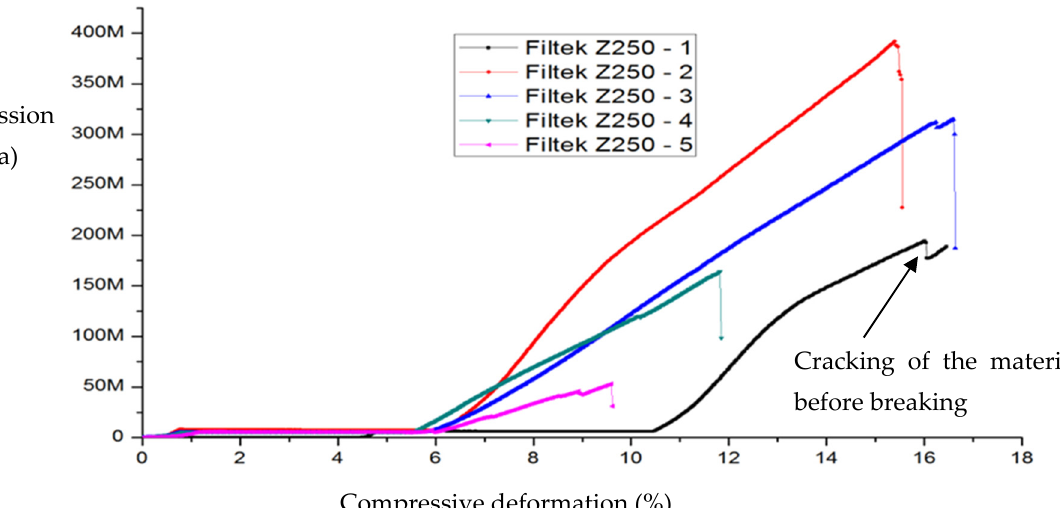
Figure 1. Variation of compressive strain with compressive stress for Filtek Supreme XT composite specimens.